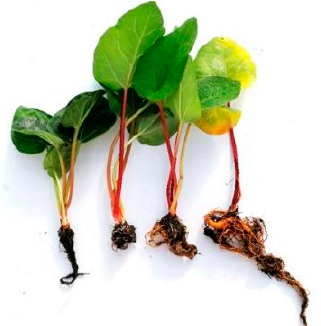
Figure 10. Ex vitro growth of micropropagated rhubarb plantlets after different growth periods in a greenhouse; from the left, after 1, 2, 3 and 4 months of growth in the greenhouse.